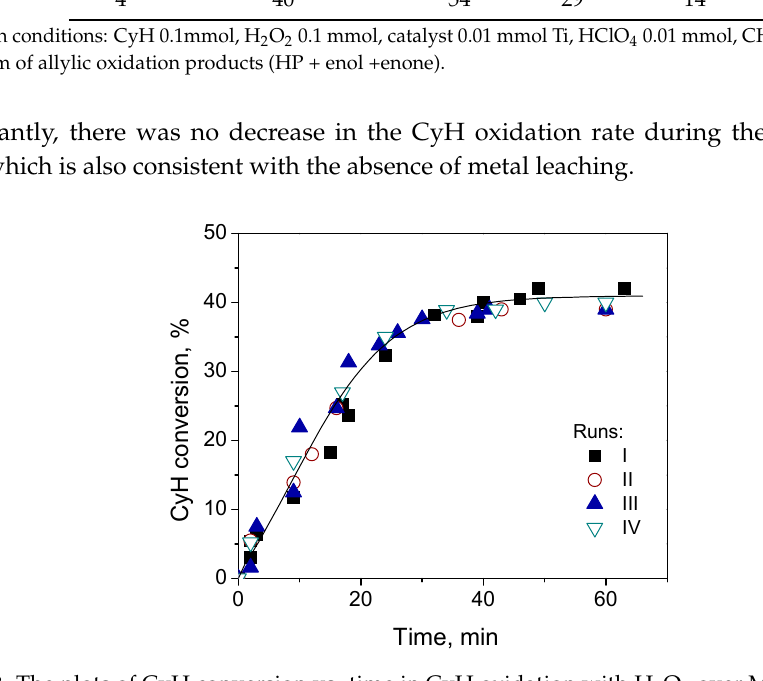
Table 4. The reuse of MIL-125-L in CyH oxidation with H 2 O 2 in the presence of 1 equivalent of 1 h. b Sum of allylic oxidation products (HP + enol +enone).